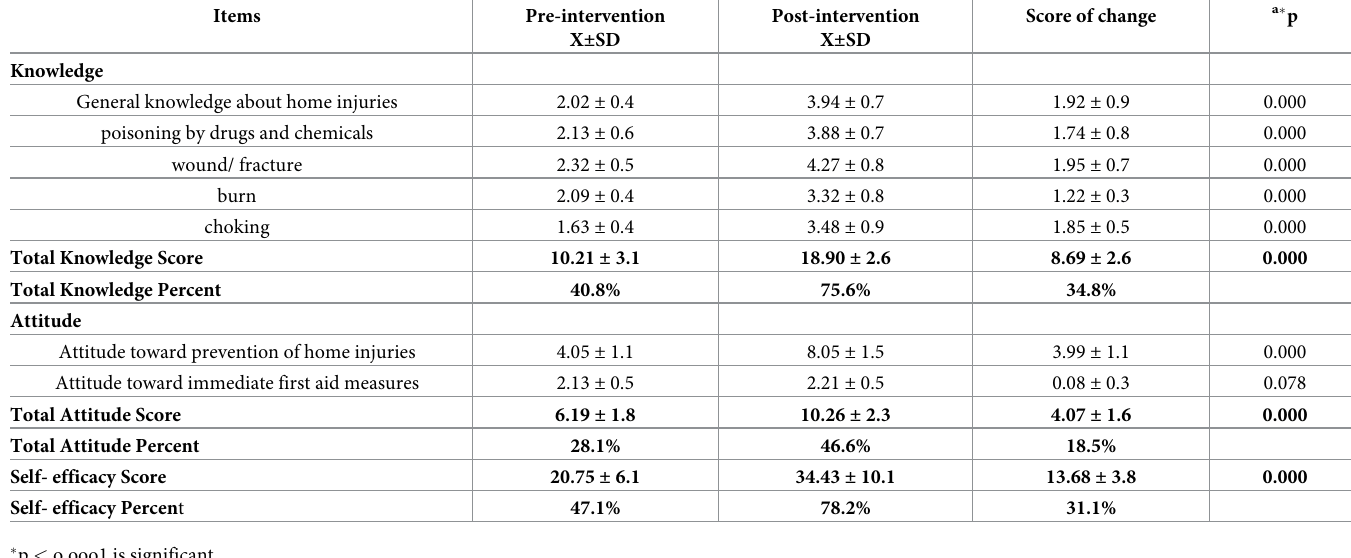
Table 3. Mother’s knowledge, attitude, self-efficacy about prevention of home injuries and basic first aid measures.